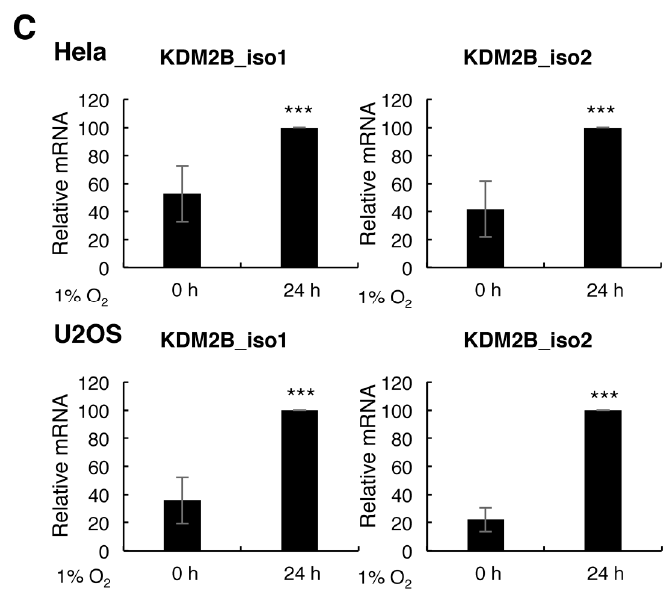
Figure 2. Hypoxia induces KDM2A protein but has little effect on KDM2B protein levels. ( A ) U2OS and HeLa cells were exposed to 1% O 2 for the depicted times prior to cell lysis. Western blot was performed for the levels of the indicated proteins. Nonspecific band is labelled ns; ( B ) HeLa and U2OS were grown on coverslips and exposed to 1% O 2 for the times depicted prior to fixation with methanol. Cells were stained with anti-KDM2B, HIF-1 α antibodies, and DAPI to mark chromatin. Scale bar represents 10 µ m. Images were acquired using a Deltavision microscope, and deconvolved and analysed using Omero software. Pixel intensities were quantified in Omero using the region of interest (ROI) tool. Graph depicts mean and standard deviation (SD) of a minimum of 100 cells per condition. Student t -test was performed and p value calculated. * p < 0.05, *** p < 0.001.